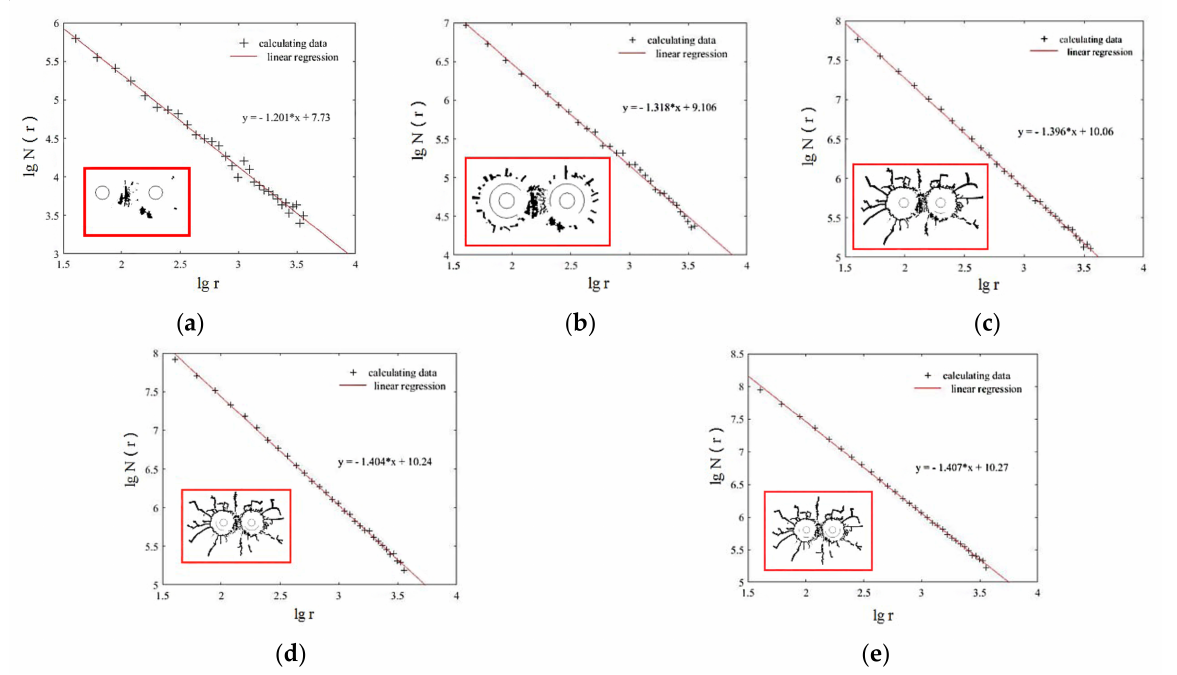
Figure 5. The 90 mm aperture, 630 mm aperture fractal dimension and damage evolution process. ( a ) At 1 us after explosion; ( b ) 2 us after explosion; ( c ) 3 us after explosion; ( d ) 4 us after explosion; ( e ) 5 us after explosion.